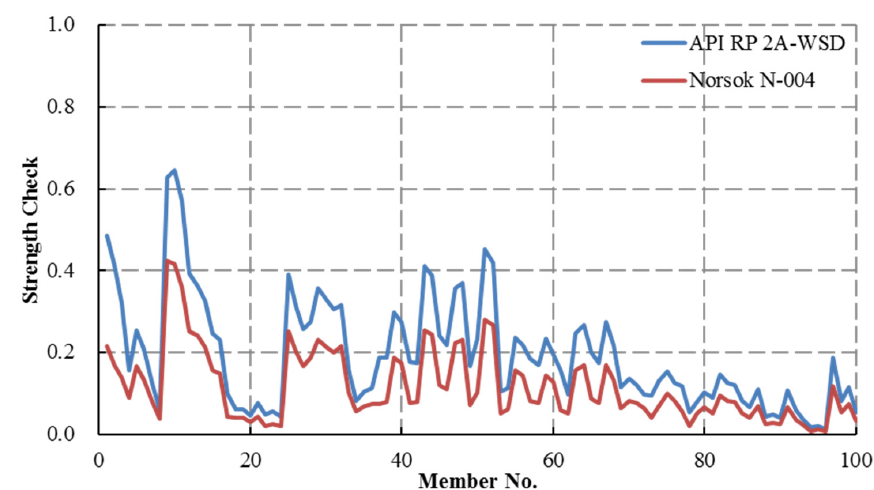
Figure 21. Member Strength Check (Case 3).